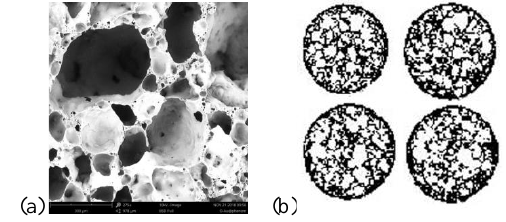
Fig. 2. Microscope images of LWCA particle: (a) SEM iamge, and (b) X-ray tomography image .